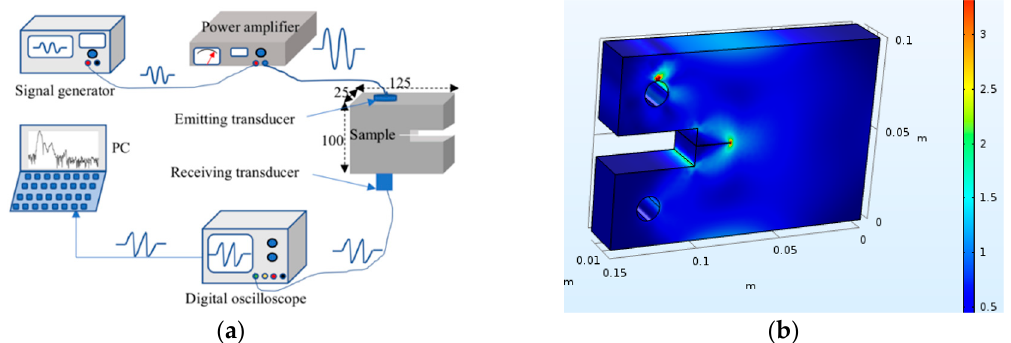
Figure 5. ( a ) The experiment system. ( b ) The stress distribution during the fatigue test.